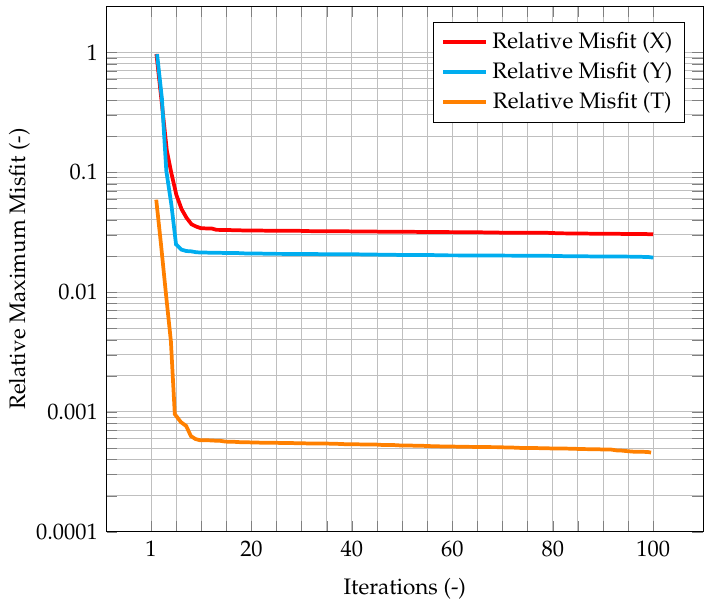
Figure 15. Time evolution of the maximum normalized misfit between observation and solution. Note that the velocity is not actually corrected by the filter; rather, temperature is corrected, and this augmented value is used in the prediction of the velocity field.